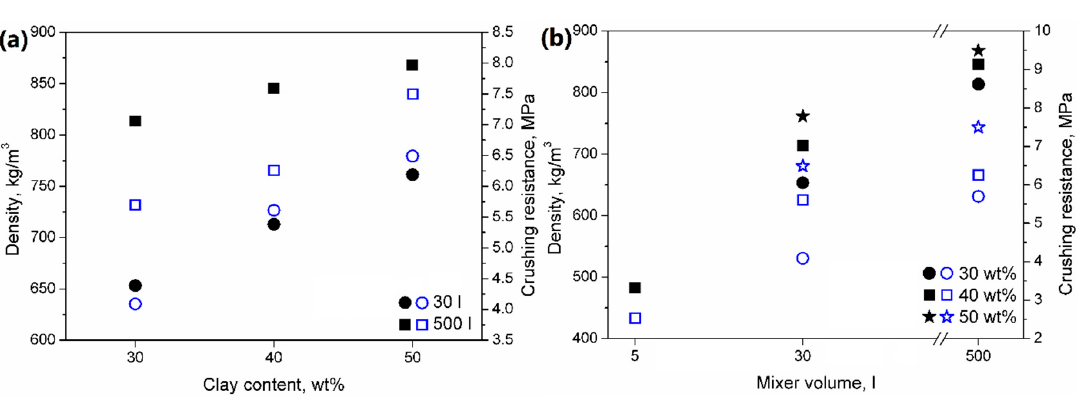
Figure 3. The e ff ect of ( a ) clay content and ( b ) mixer volume on the ( • , (cid:4) , (cid:70) ) bulk density and ( Figure 3. The effect of ( a ) clay content and ( b ) mixer volume on the ( ● , ■ , ★ ) bulk density and ( ○ , □ , ☆ ) crushing resistance of obtained crushing resistance of obtained aggregates.